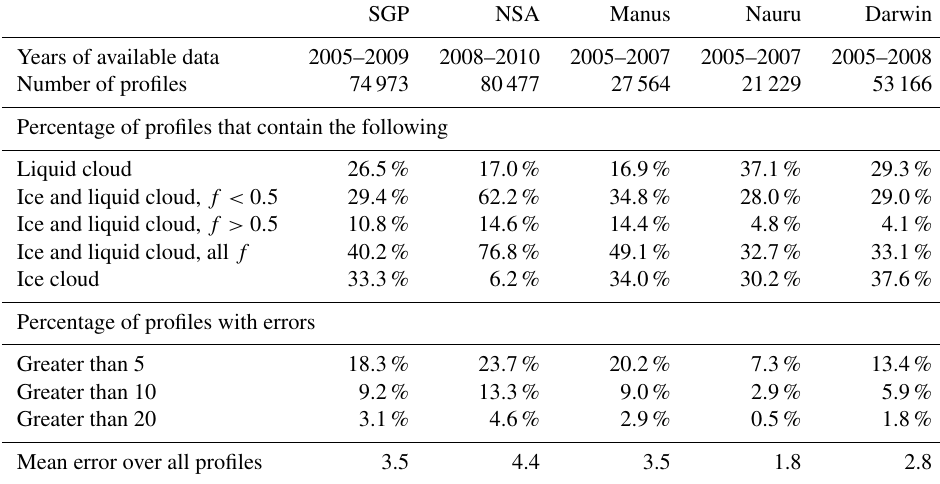
Table 1. A summary of cloud statistics across the five ARM sites discussed in this study. Profiles included in these statistics consist only of those from the ARM Mace dataset at times when an AERONET cloud mode retrieval would have been possible (see third and fourth paragraphs of Sect. 4 for criteria). SGP NSA Manus Nauru Darwin Years of available